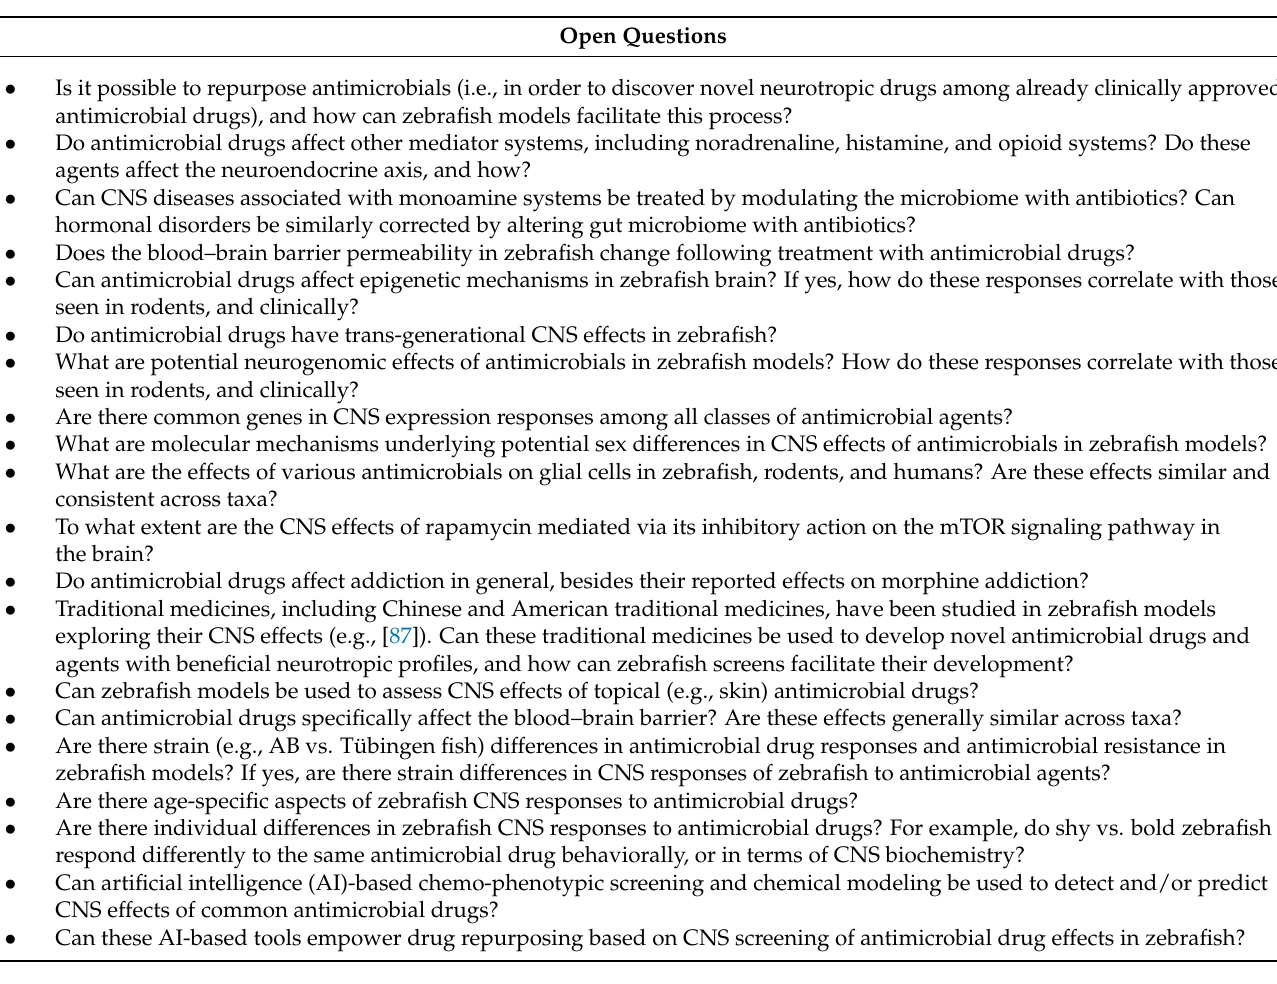
Table 2. Selected open questions related to screening CNS effects of antimicrobial drugs in